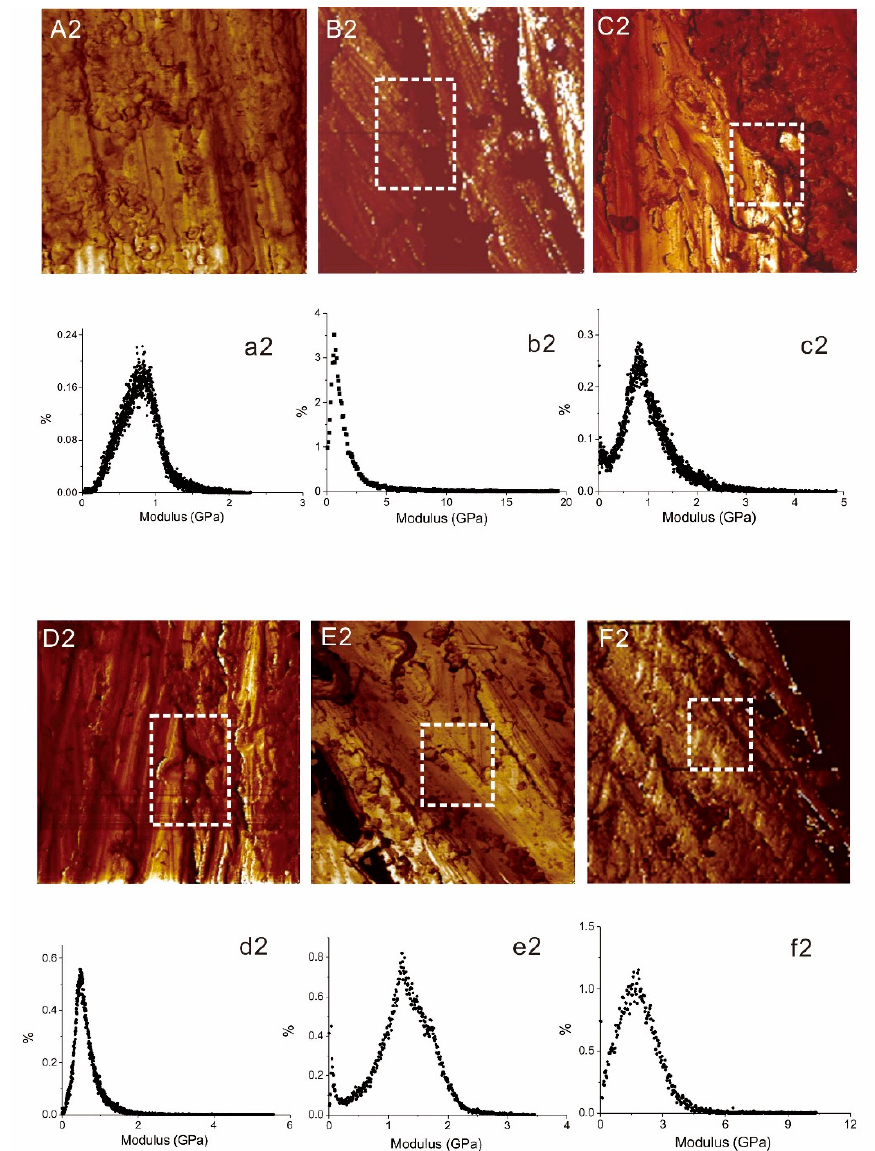
Figure 8. AFM DMT modulus maps of a 30 × 30 µ m 2 region, and the modulus distribution graphs of: FFRP ( A2 , a2 ); MP-FFML ( B2 , b2 ); MPAL-FFML ( C2 , c2 ); MPALSi-FFML ( D2 , d2 ) MPALSi; P2-FFML ( E2 , e2 ); P2Si -FFML ( F2 , f2 ).